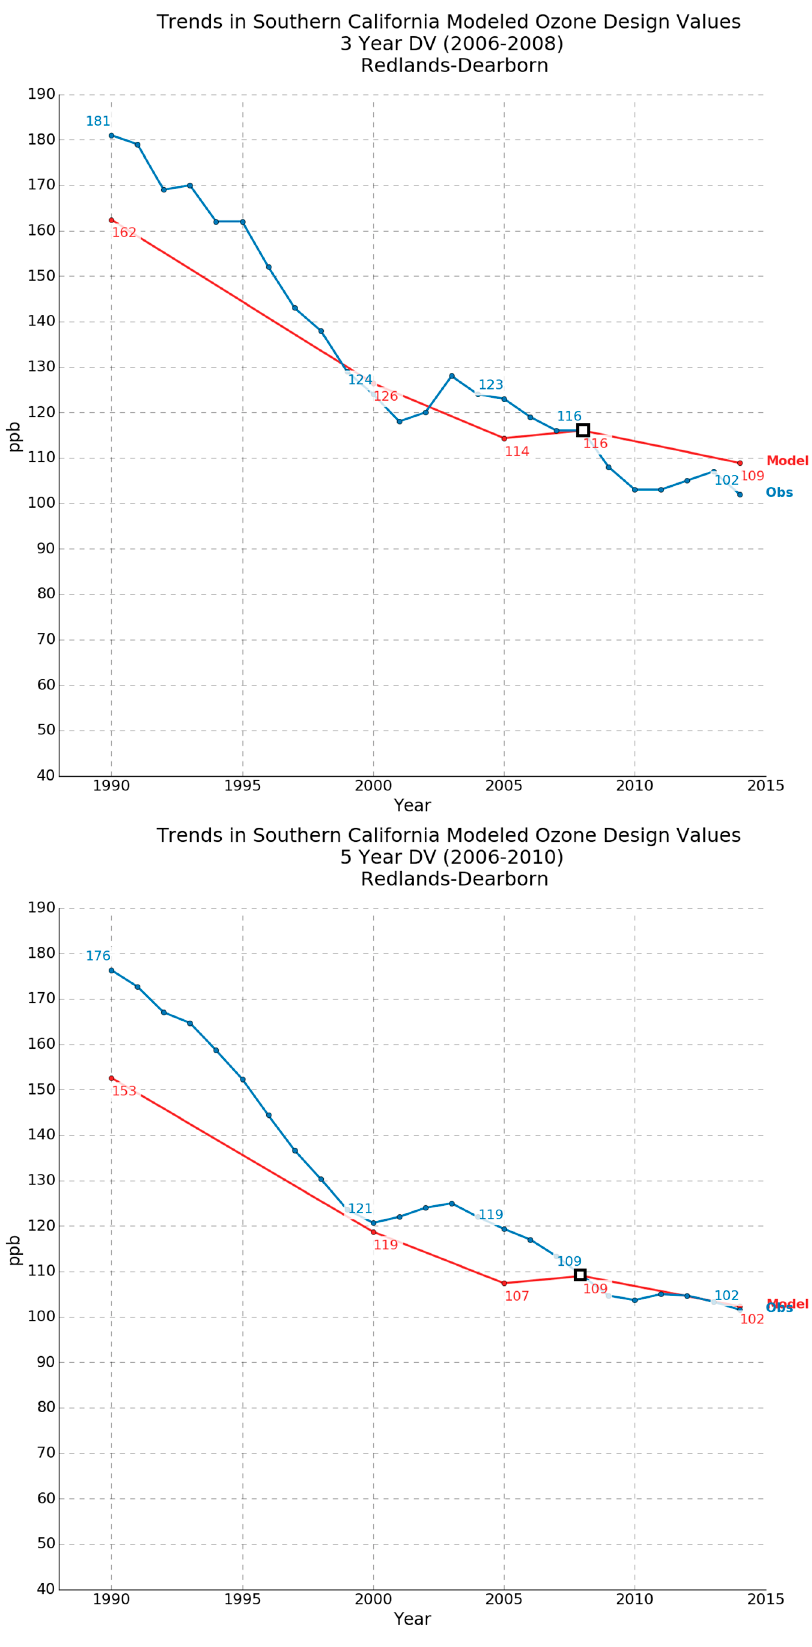
Figure 4. Modeled and observed trends in 3-year ( top ) and 5-year ( bottom ) ozone design values at the Redlands monitor from 1990 to 2014 using the 2012 AQMP modeling database. The anchor (baseline) year for the design value calculations is 2008 (marked by the square symbol in the figures).